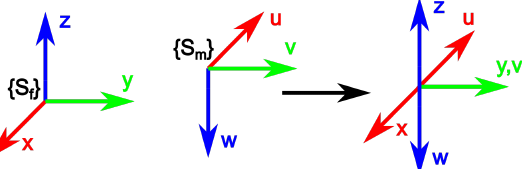
Figure 2. Example of CFs to define the orientation of a mobile